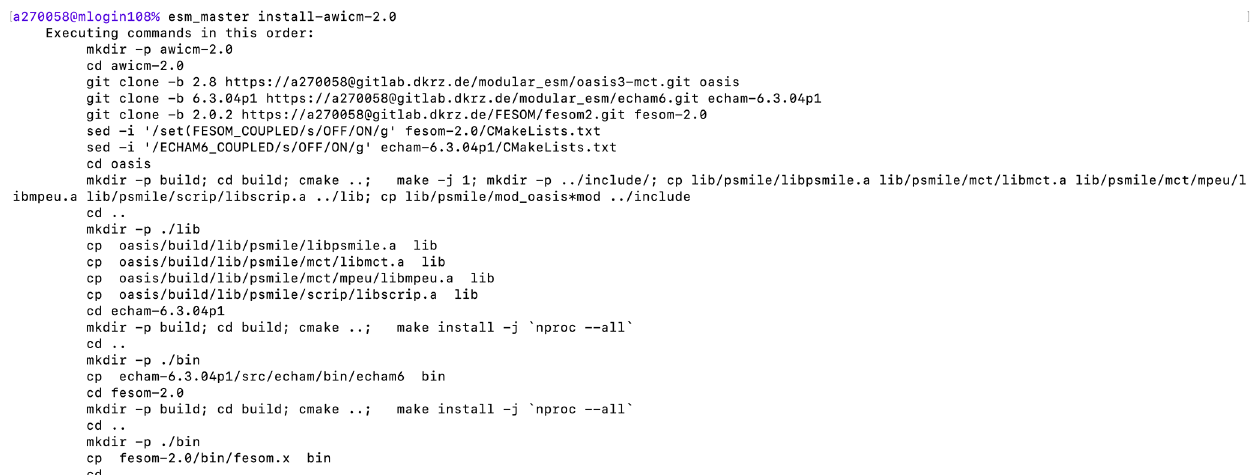
Figure 5. Output of esm_master install-awicm-2.0 , listing the steps performed by esm_master to download, configure and compile the three components echam-6.3.04p1 , fesom-2 and oasis3mct . Note that preprocessor flags are used to change the model components from the stand-alone to the coupled configurations.